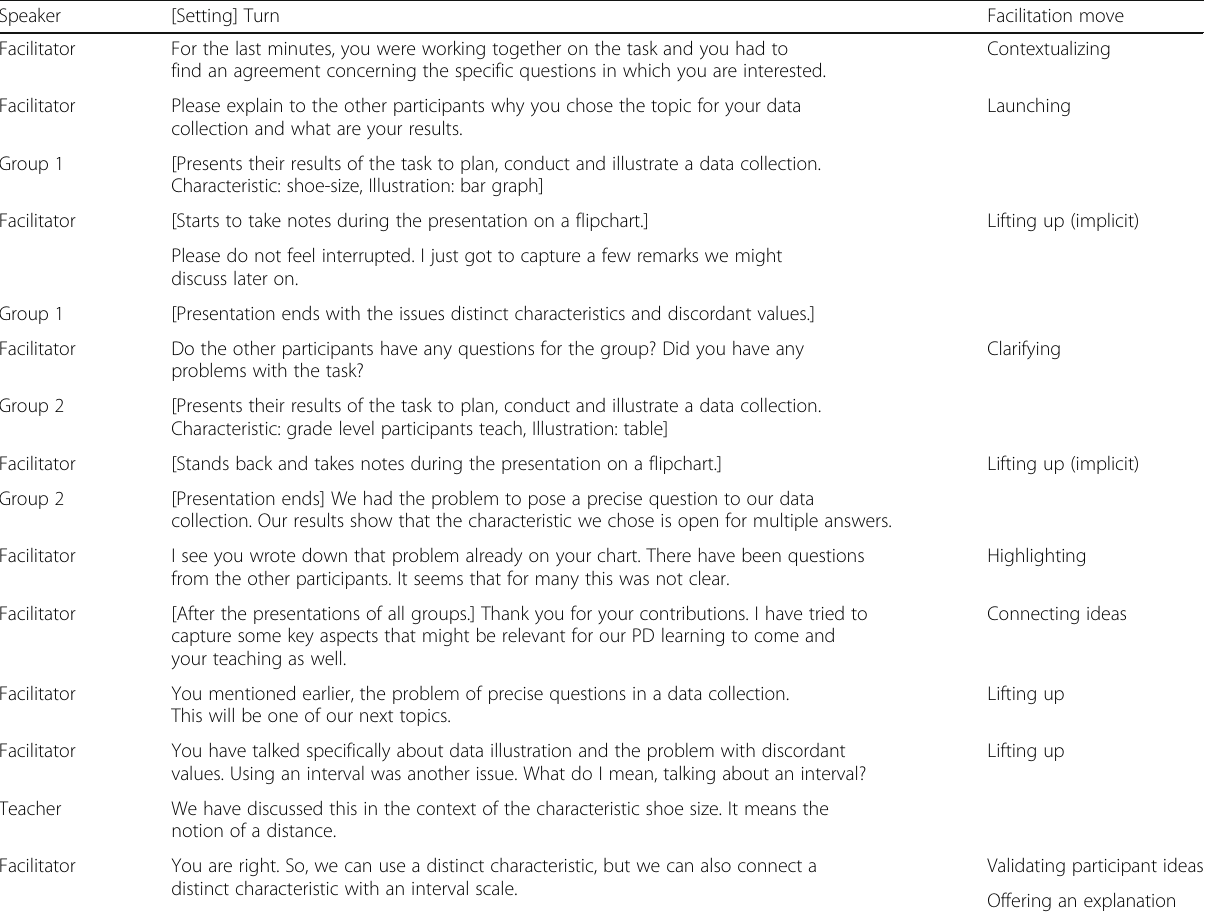
Table 4 Example of assigning facilitation moves to video case “ Representing characteristics ” Speaker [Setting] Turn